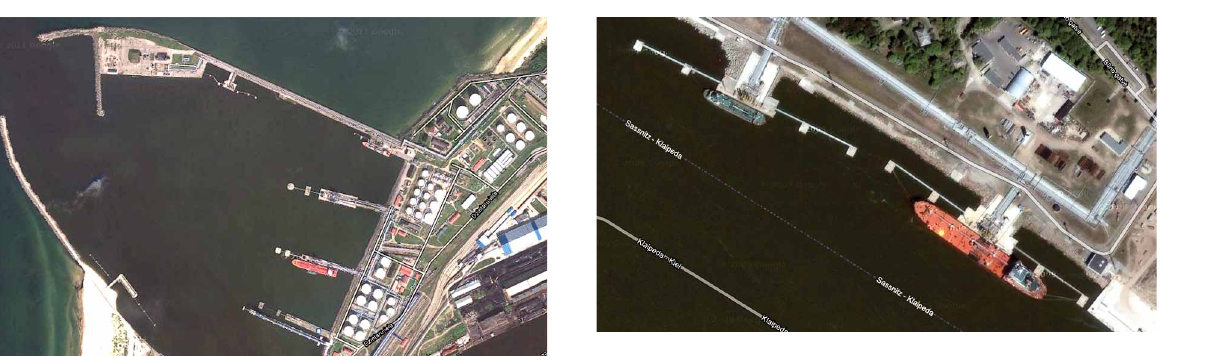
Fig. 3 . Quays at the oil terminal in the Port of